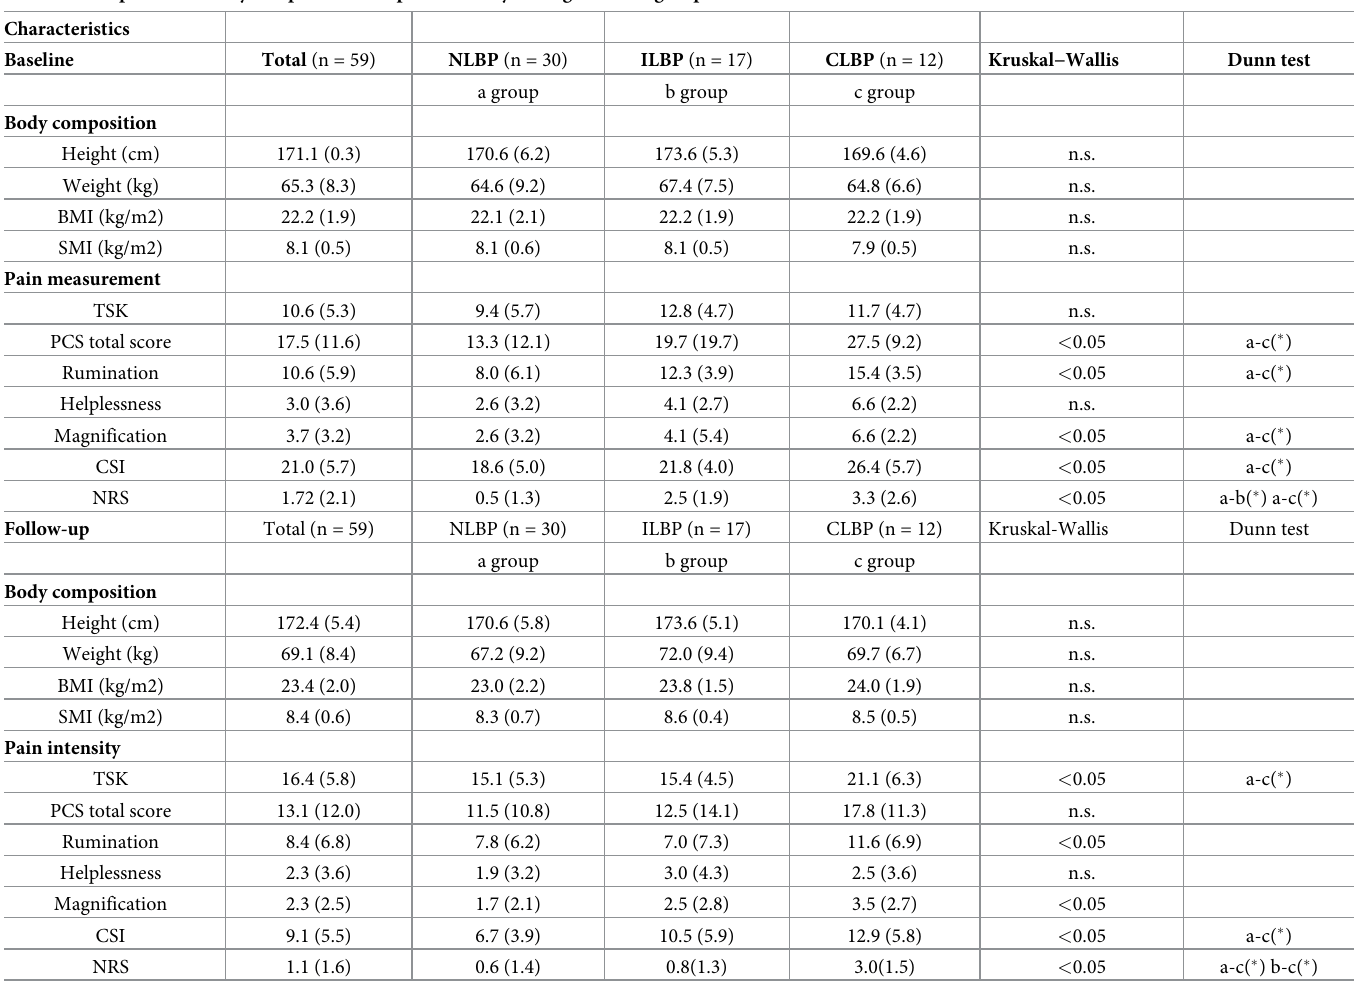
Table 2. Comparison of body composition and pain intensity among the three